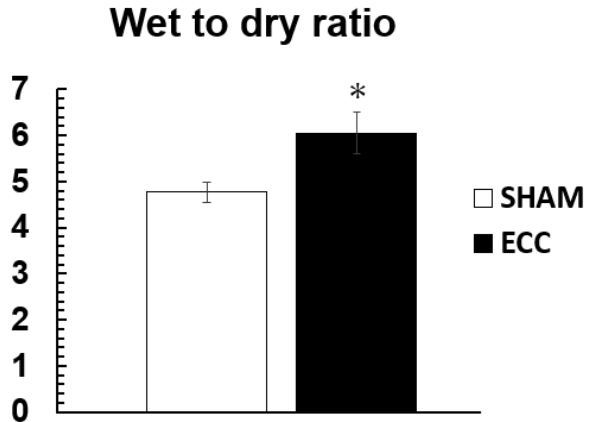
Figure 4. Wet-to-dry ratio of the left lung at the end of extracorporeal circulation. * p < 0.05 versus SHAM group.